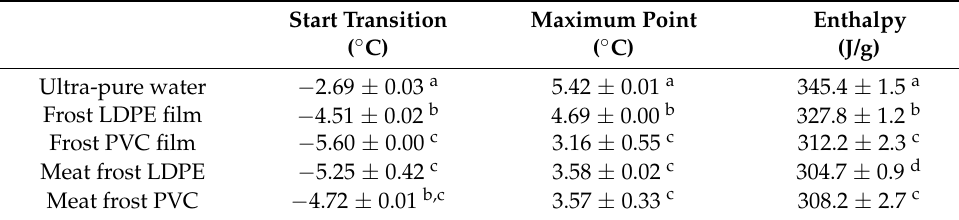
Table 5. Starting temperatures-maximum melting point and enthalpies of frost water.